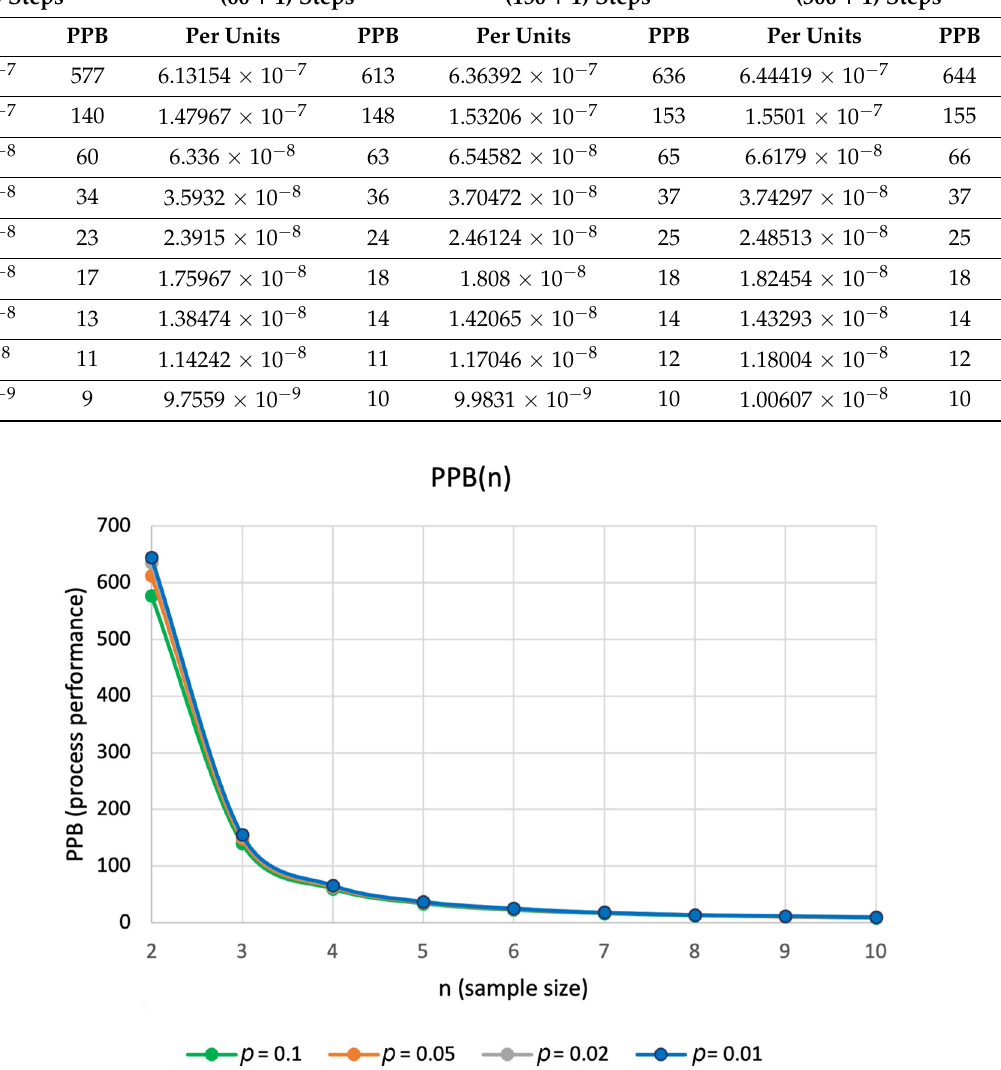
PPB(n), for p = 0.01